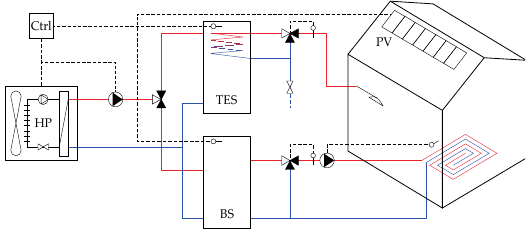
Figure 3. Schematic diagram of the heating system.